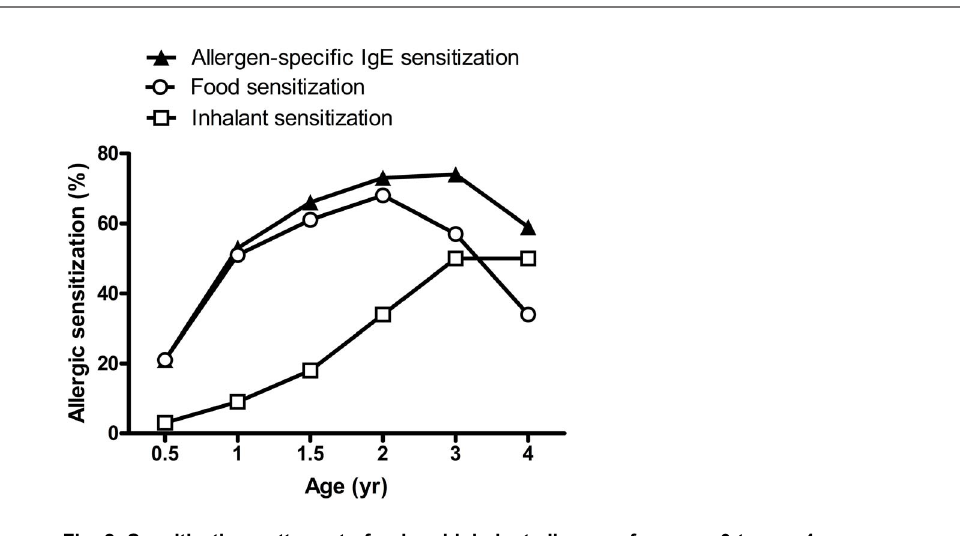
Fig. 2. Sensitization patterns to food and inhalant allergens from age 0 to age